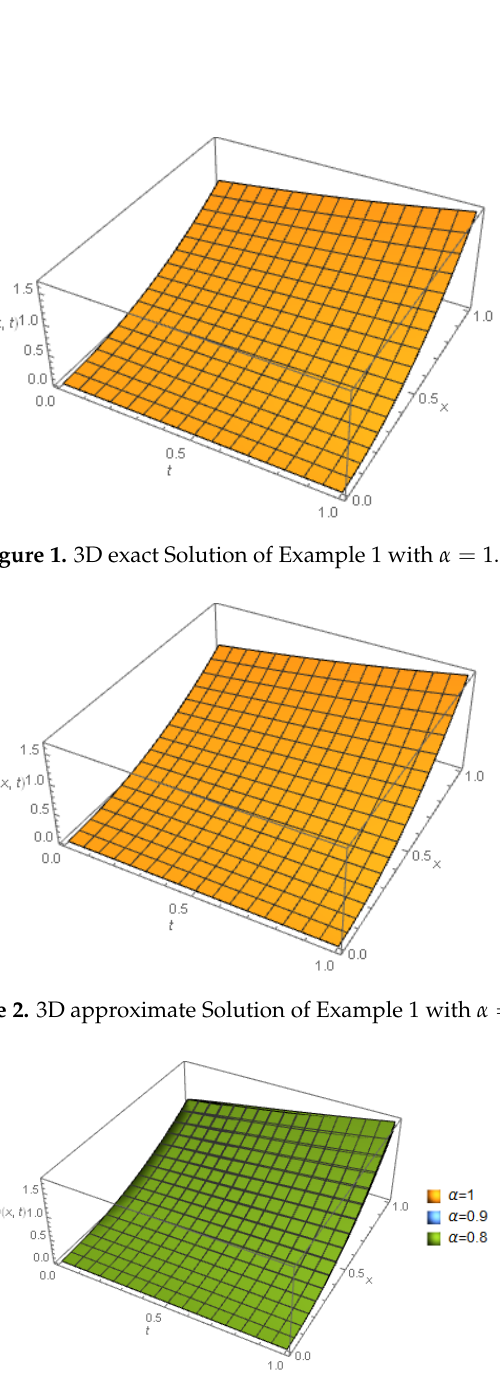
Figure 3:3D Solutions of example1 with di⁄erent Figure4: Absolute error of example1 at (cid:11) = 1 Figure 3. 3D Solutions of Example 1 with different values of α values of (cid:11) Figure4: Absolute error of example1 at (cid:11) = 1